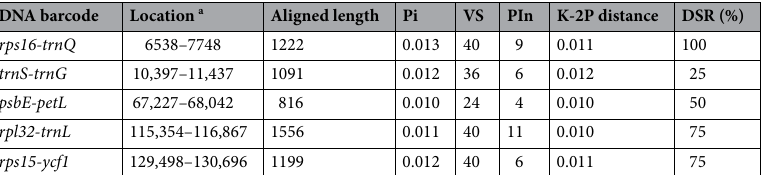
Table 2. Comparative analysis of five hypervariable fragments in Citrullus . a The location of five hypervariable fragments is confirmed based on the chloroplast genome of C. lanatus subsp . vulgaris. VS Variable sites, Pin Parsimony informative sites, DSR Discrimination success ratio.